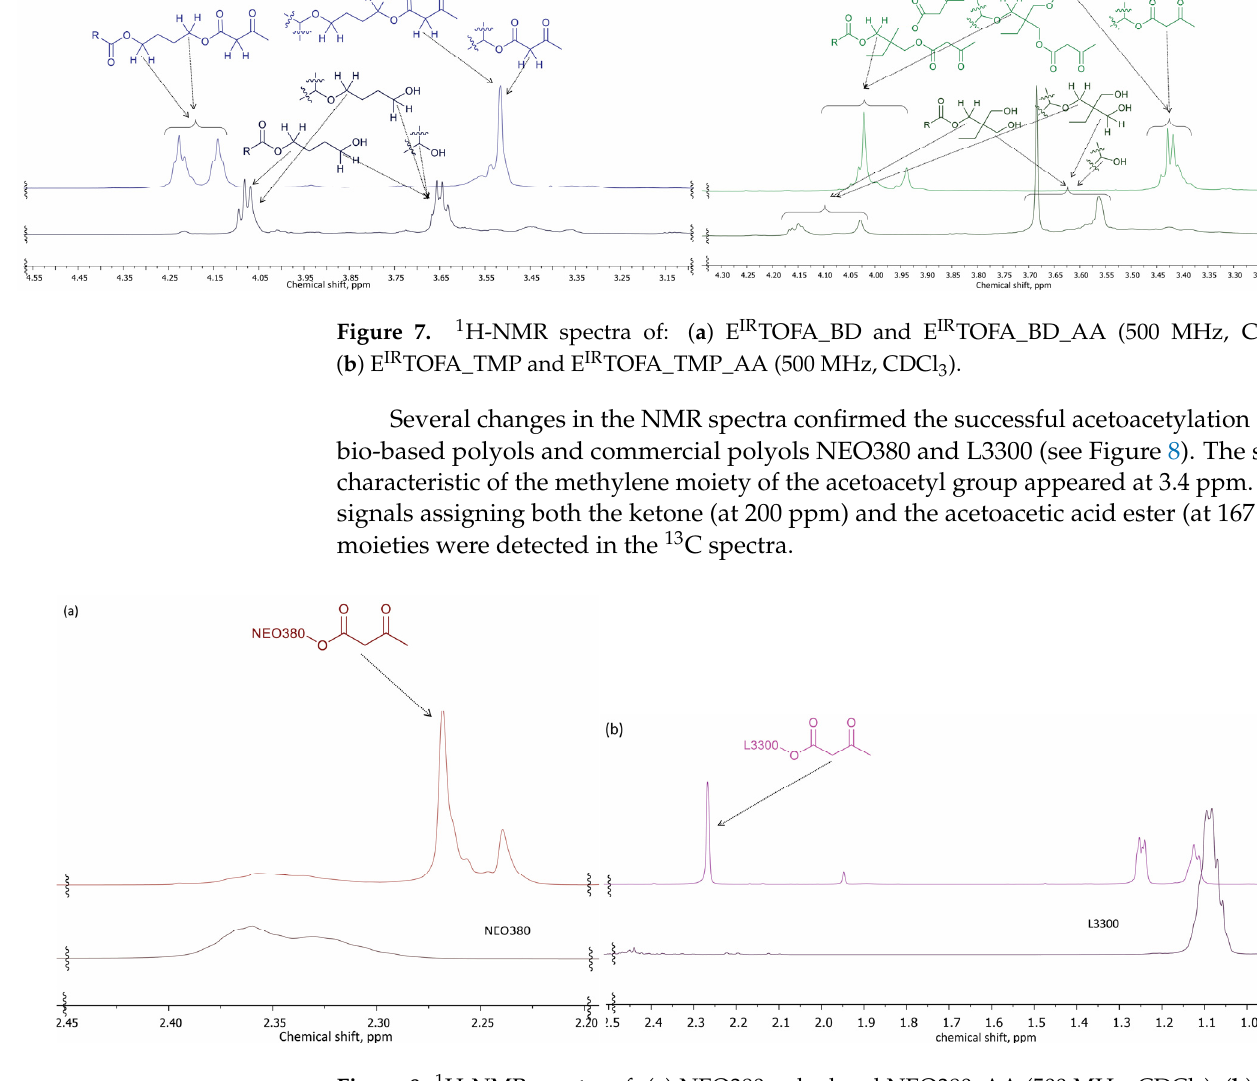
Figure 8. 1 H-NMR spectra of: ( a ) NEO380 polyol and NEO380_AA (500 MHz, CDCl 3 ); ( b ) L3300 polyol and L3300_AA (500 MHz, CDCl 3 ).